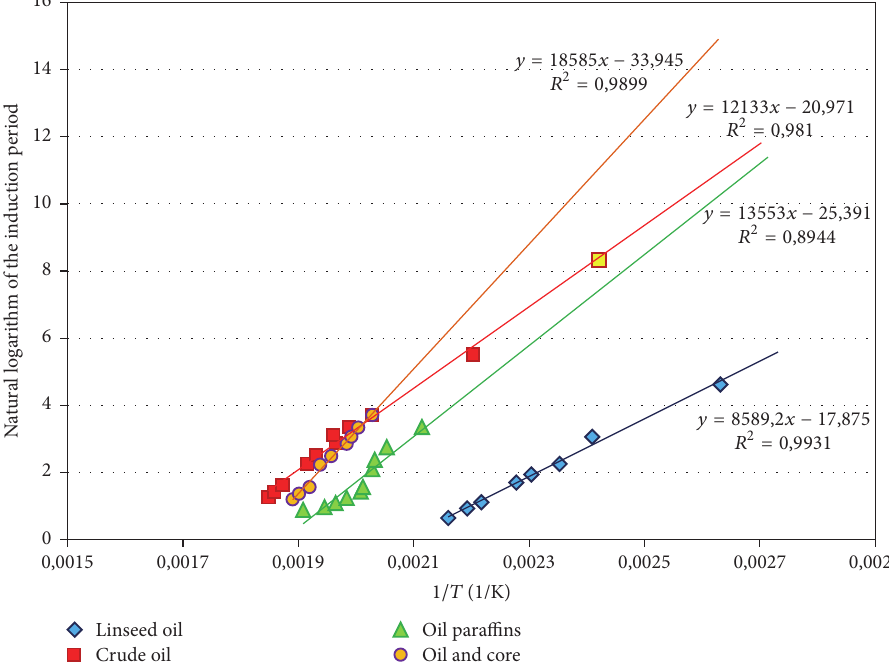
Figure 7: Dependence of the natural logarithm of crude oil heating time from the reverse temperature of self-ignition, obtained in PDSC experiments of oxidation. The yellow box is the data obtained from ARC experiment, which agree with DSC